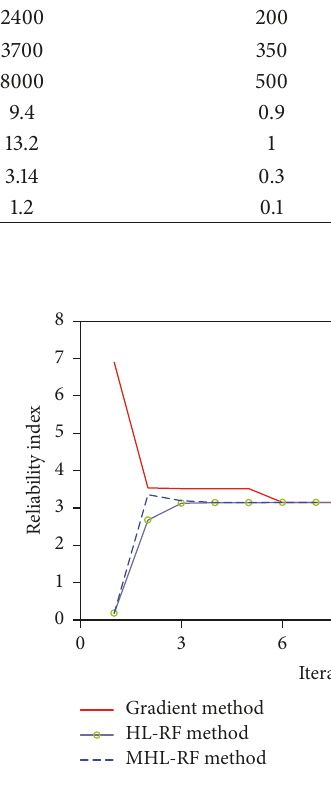
Figure 14: Convergence histories of reliability index for connection